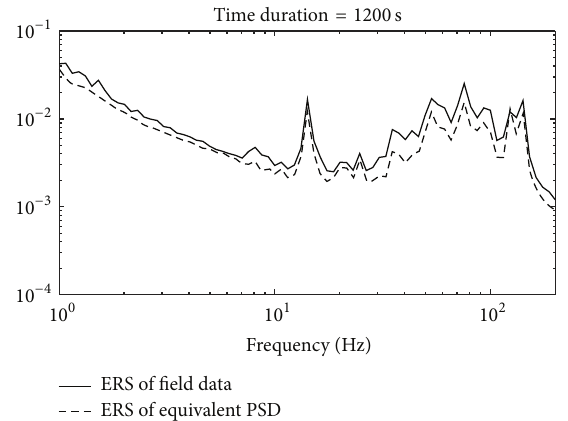
Figure 16: The ERS of the field data and the equivalent PSD ( 𝑇 = 1200